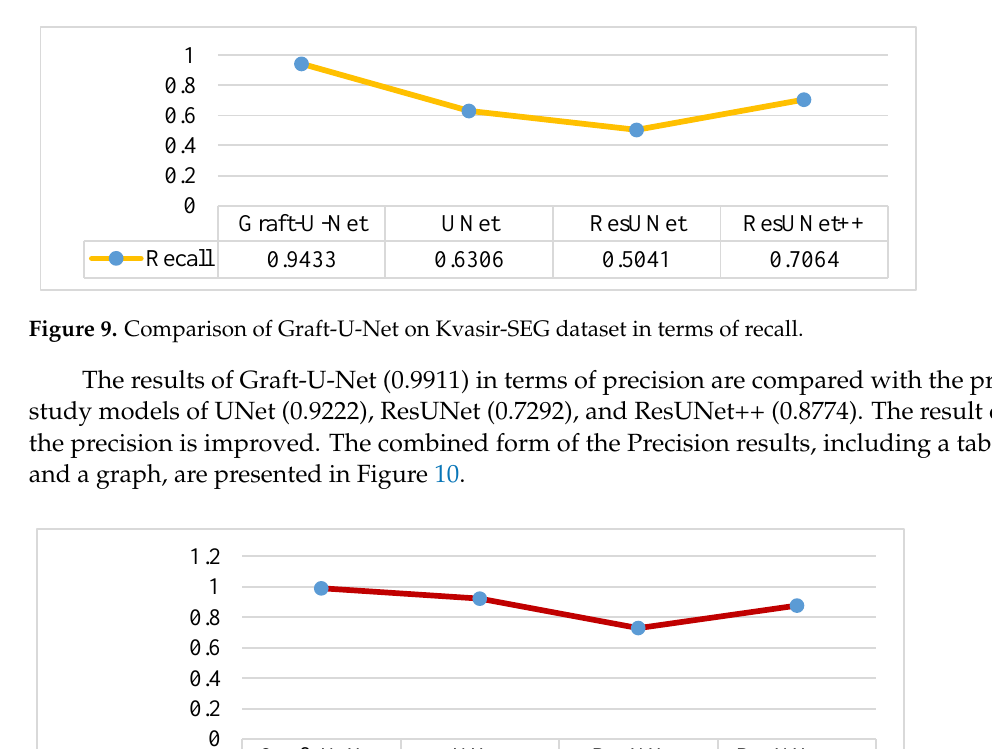
recall is illustrated in the form of a table and a graph in Figure 9.